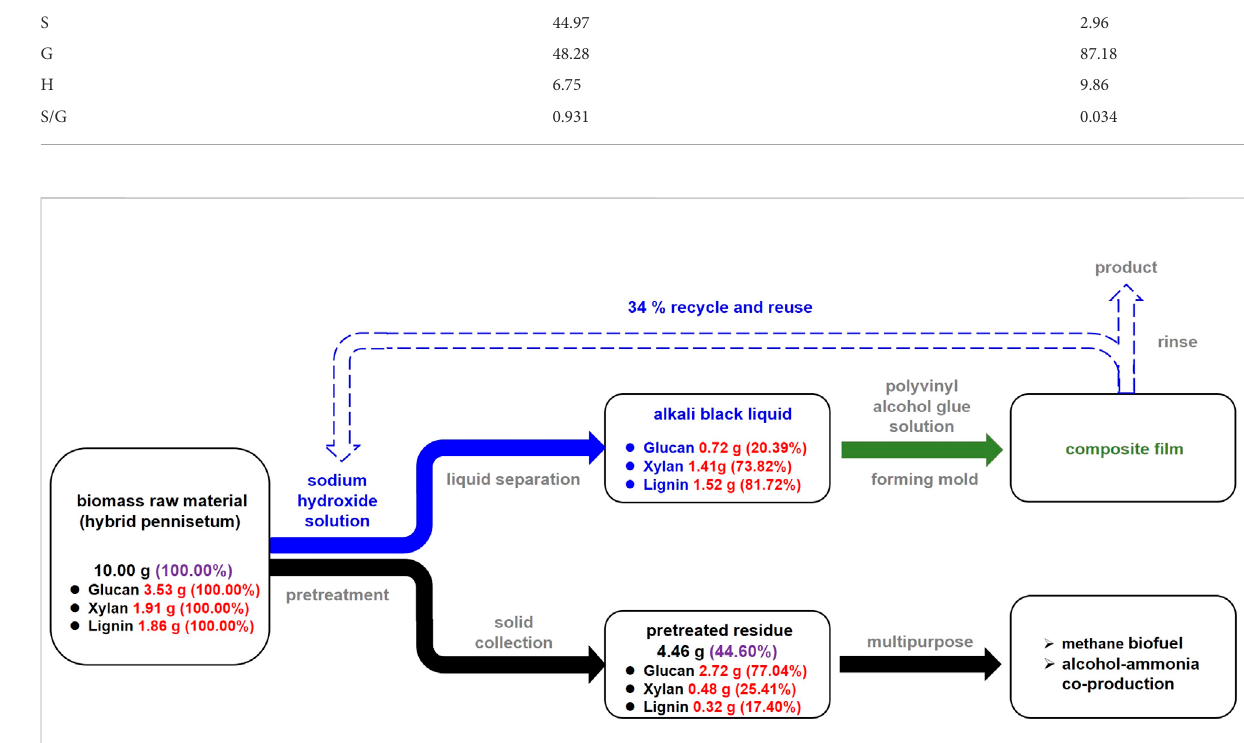
FIGURE 9 Aproposedschematicoftheintegratedvalorizationofhybrid Pennisetum byco-producing biodegradableUV-shielding fi lmsandbiofuelswith mass fl ow.